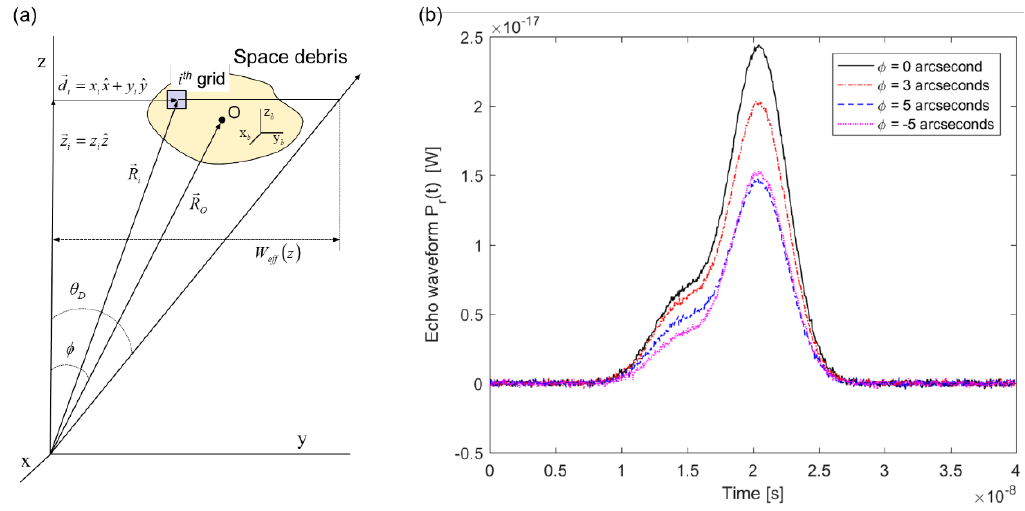
Figure 3. ( a ) Beam spreading and ( b ) broadening, due to the atmospheric turbulence.